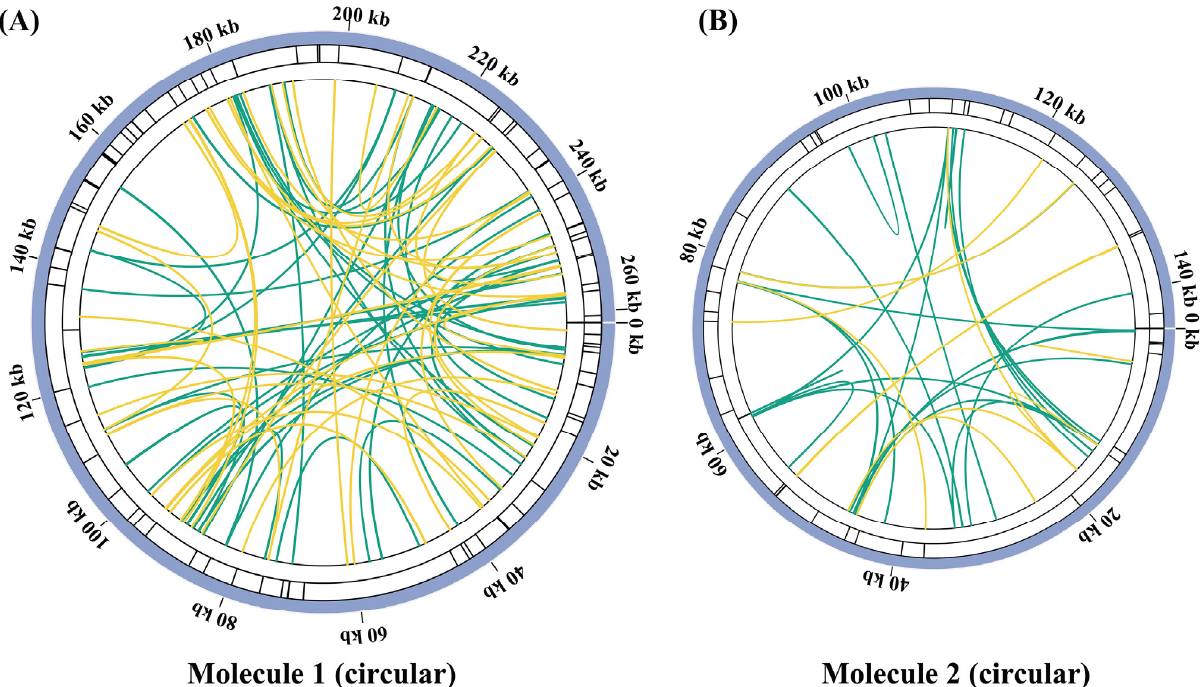
Figure 3. Repeat analysis of the mitochondrial genome in G. elegans . ( A , B ) Repeated sequences were analyzed for each of the two chromosomes. The colored lines on the innermost circle connect the two repetitive sequences of the scattered repeats, with the yellow line representing palindromic match and the green line representing forward match. The black line on the second circle represents the tandem repeat sequence, and the black line on the outermost circle represents the microsatellite or simple sequence repeat (SSR) sequence.